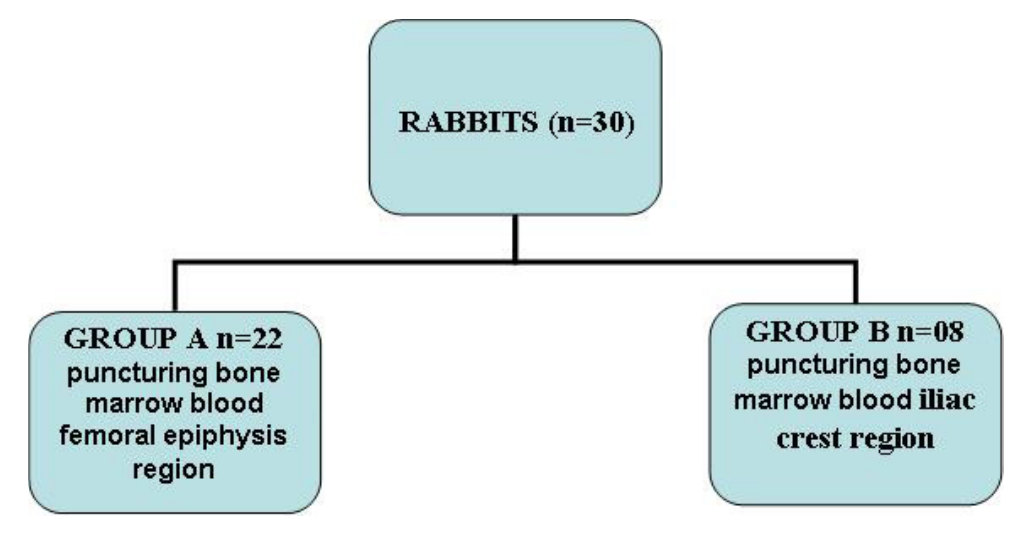
FIGURE 1 - Animals distribution in different study